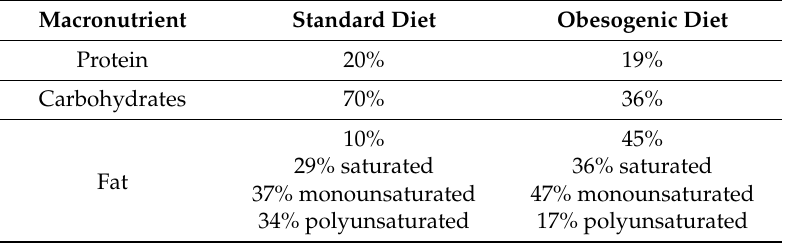
Table 2. Composition of experimental diets. Values represent the percentages of each nutrient per total